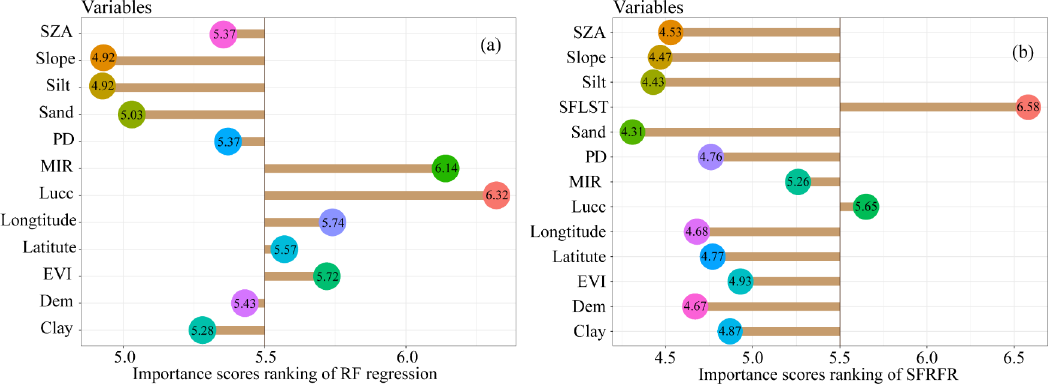
Figure 9. Importance score rankings of the model results: ( a ) RF regression and ( b ) SFRFR.